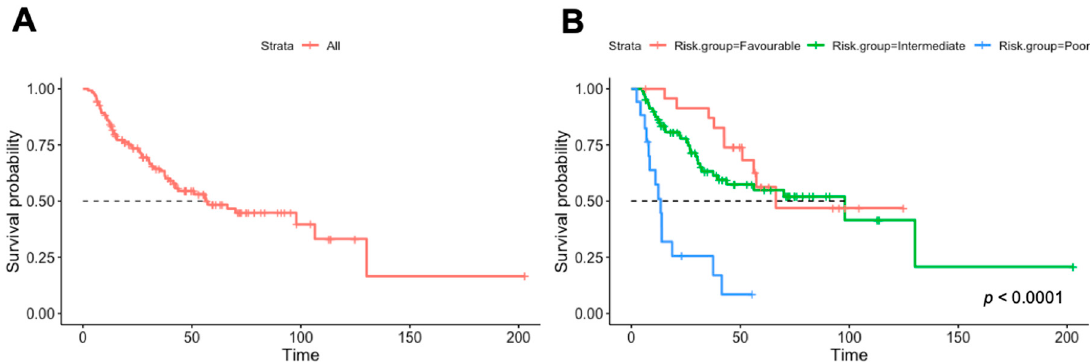
Figure 1. Kaplan–Meier plots of overall survival of all patients ( A ) and by Heng risk groups ( B ). p -value calculated by a Cox proportional hazard regression model.